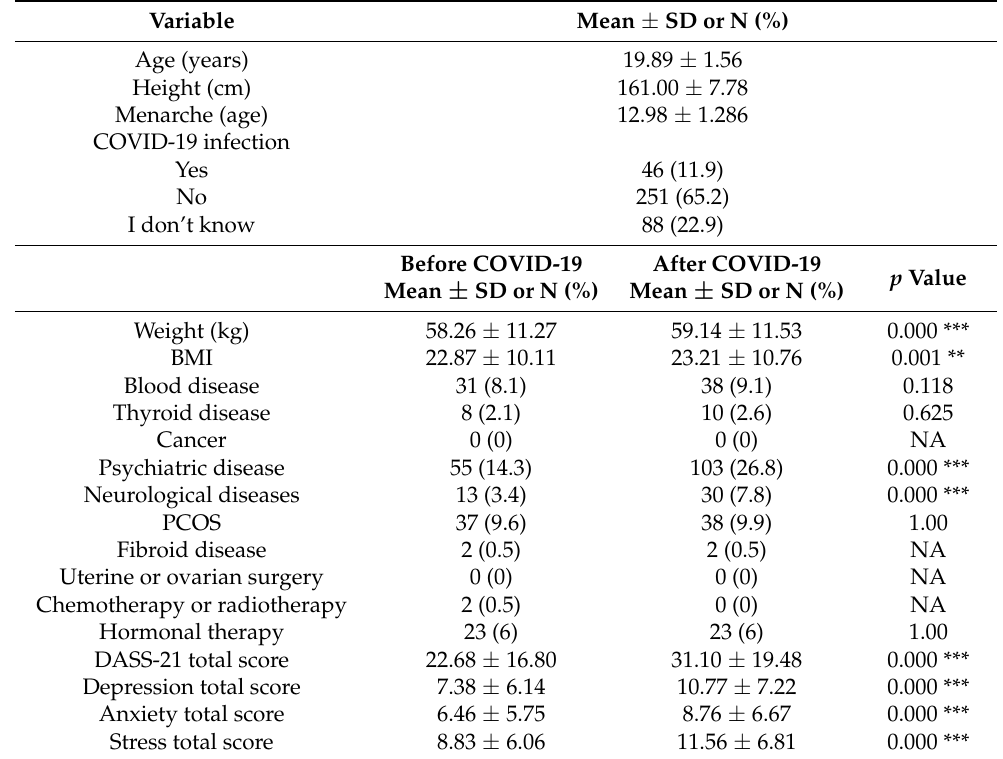
Table 1. Demographics, medical history, COVID-19 status and Depression, Anxiety and Stress Scale 21 (DASS-21) of the study population ( n = 385).